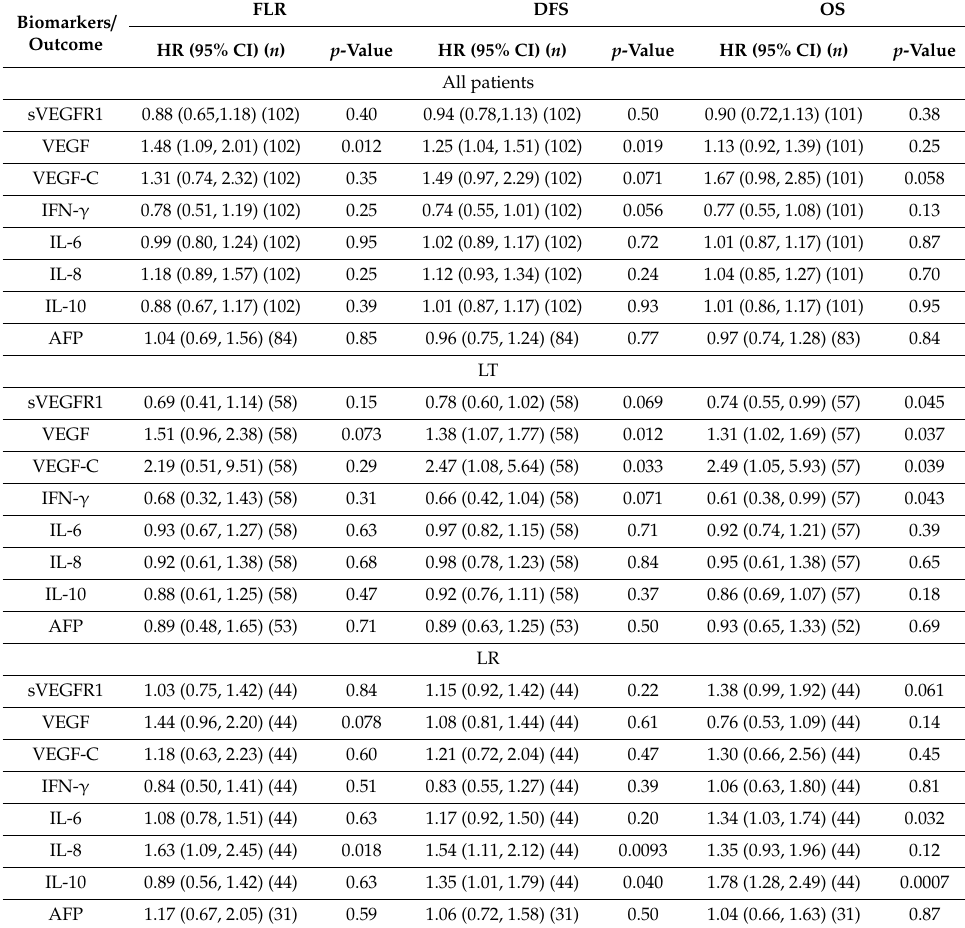
Table 4. Association between selected plasma biomarkers and freedom of liver recurrence (FLR), disease-free survival (DFS) and overall survival (OS) in hepatocellular carcinoma patients who underwent surgical treatments. p -Value from Wald test in a univariable Cox regression using log-transformed